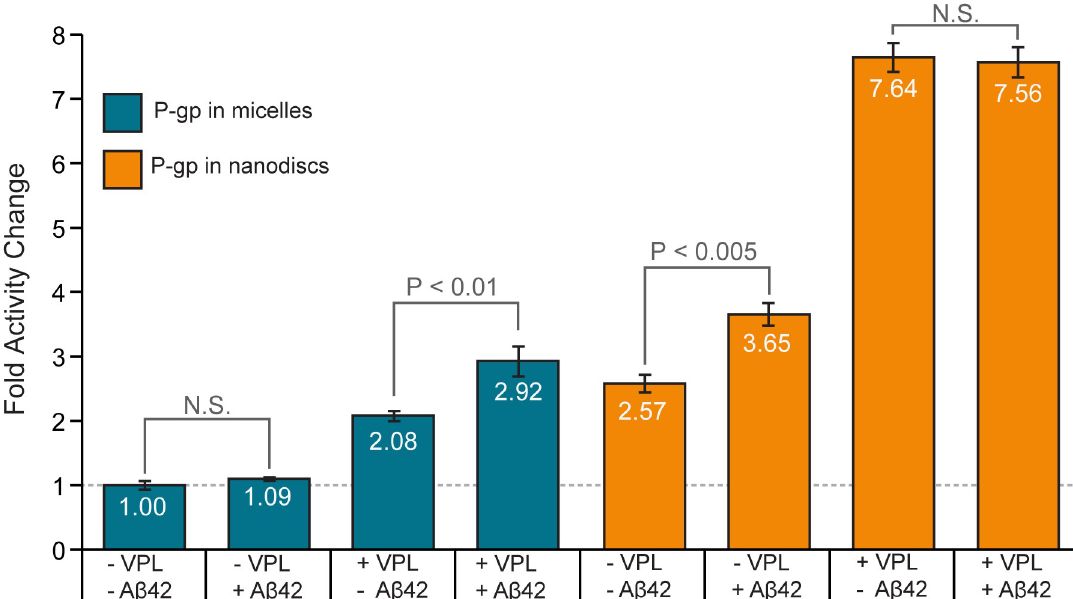
Fig 3. The effect of amyloid- β 42 on the ATPase activity of P-gp in micelles and nanodiscs. The effect of verapamil (VPL) and A β 42 on the rate of ATP hydrolysis by P-gp was measured in micelles and in nanodiscs. All samples are normalized to the basal ATPase rate of P-gp in micelles (blue bars). Error bars represent ± one standard deviation from the mean. For P-gp in micelles, 12.8 μ M A β 42 and 712 nM P-gp were used; for P-gp in nanodiscs, 9.6 μ M A β 42 and 534 nM P-gp were used–both corresponding to a molar ratio of 1:18. A VPL concentration of 150 μ M was used, as in